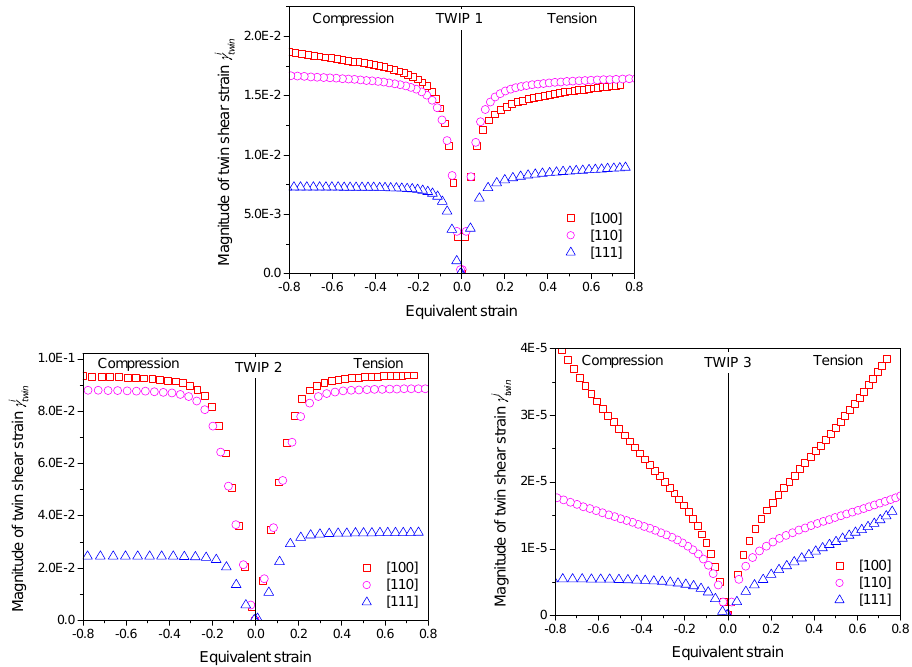
Figure 11. Magnitude of commulative twin shear strain of a single crystal of TWIP steels subjected to tension and